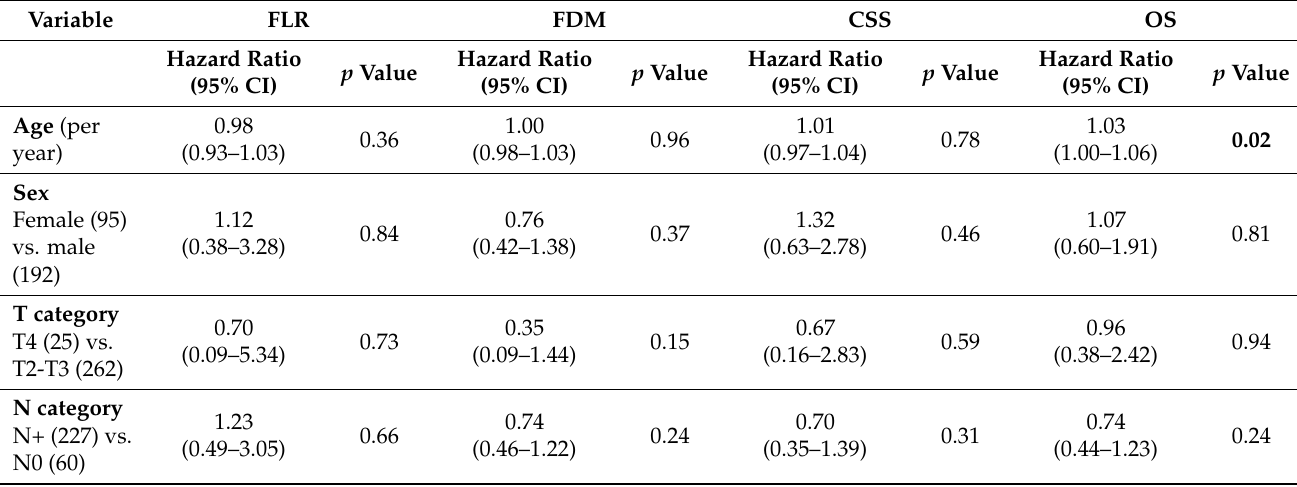
Figure 2. Kaplan–Meier plots for freedom of local recurrence (FLR), ( A ), freedom from distant metastasis (FDM), ( B ), cancer- specific survival (CSS), ( C ), and overall survival (OS), ( D ), depending on the histopathological nodal status (ypN) at time of surgical tumor resection upon neoadjuvant radiochemotherapy. The two groups, i.e., ypN+ vs. ypN0, were statistically compared by the log-rank test. Table 3. Univariable Cox regression for assessing the impact of patient baseline, tumor, treatment, and OGG1 genotype on freedom from locoregional relapse (FLR), freedom from distant metastasis (FDM), cancer-specific survival (CSS), and overall survival (OS). Nominal p values < 0.05 are highlighted in